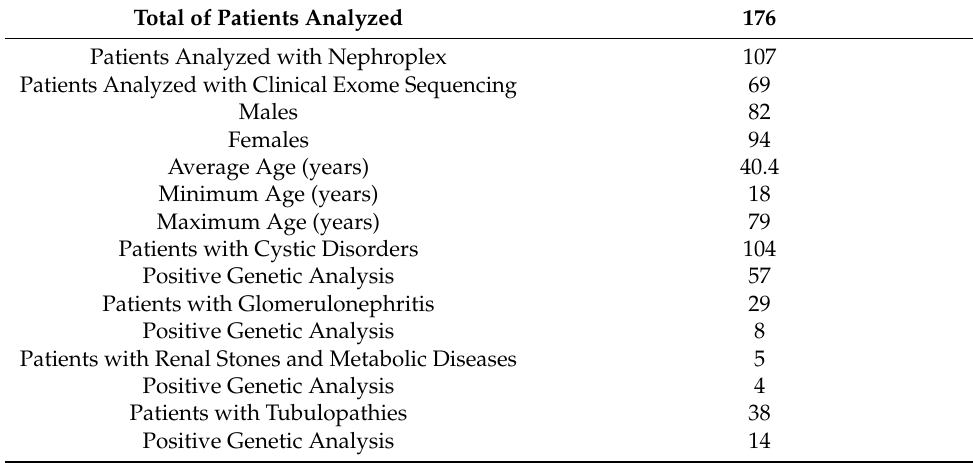
Table 1. Main features of patient cohort. The cohort consisted of individuals with different inherited kidney disorders. Age, gender, clinical diagnosis, and diagnostic rate are listed in the table. Total of Patients Analyzed 176 Patients Analyzed with